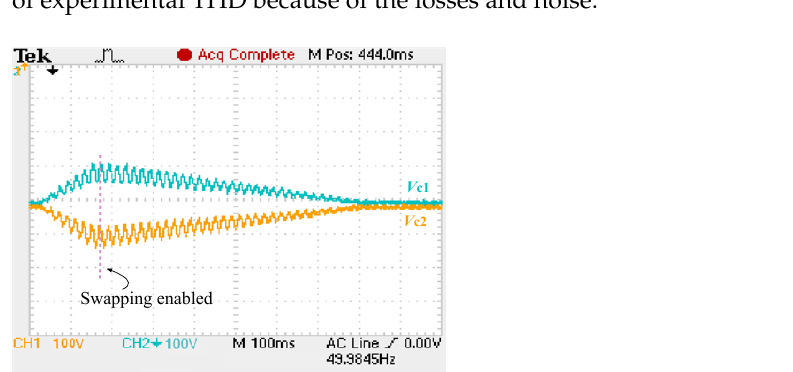
Figure 13. Balanced DC-link capacitor voltage, traces channel 1 and 2 (100